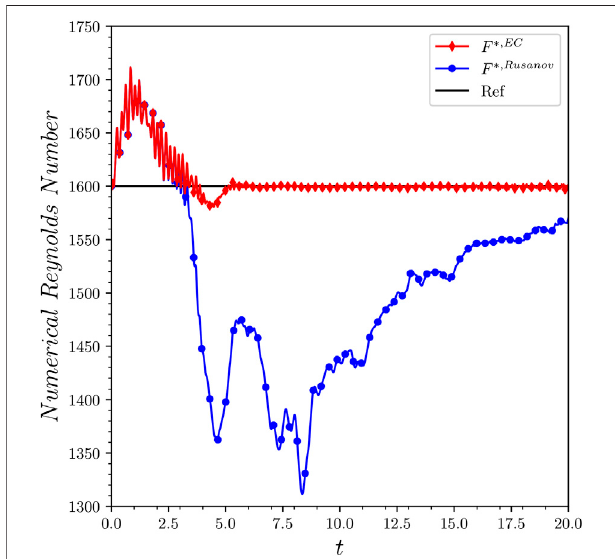
FIGURE 1 | The estimate of the numerical Reynolds number of an under resolved simulation with polynomial degree N (cid:3) 7 and eight elements (64 3 DOF). The physical Reynoldsnumber ofthe Taylor-Green vortex setup is Re (cid:3) 1600. The entropy conservative (EC) scheme retains the physical Reynolds number remarkably well and is virtually dissipation free. The entropy stable (Rusanov) variant clearly introduces stabilizing dissipation as soon as the scales can no longer be resolved starting at about t (cid:3)